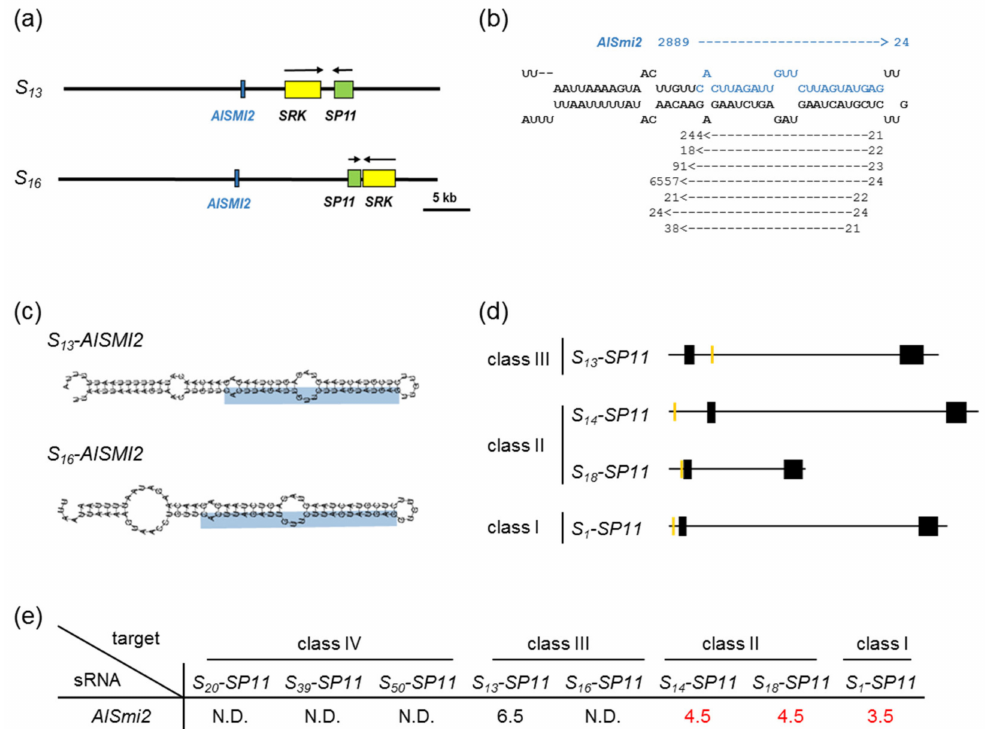
Figure 4. Identification of the candidate sRNAs controlling dominance–recessivity relationships: class III > (class II, class I). ( a ) Schematic diagrams of the S locus in the S 13 haplotype (ADBK01001387) and the S 16 haplotype (HQ379629). Green, yellow, and blue boxes indicate SP11, SRK , and AlSMI2, respectively. ( b ) Massively parallel sequencing analysis of sRNA expression from the S 13 -AlSMI2 inverted repeat sequence. sRNAs obtained from more than 10 reads were mapped against the S 13 -AlSMI2 inverted repeat sequence. Arrows indicate mapped sRNAs and their directions. Numbers at the tips of arrows indicate the obtained read numbers, and numbers at the ends of arrows indicate the base length of each sRNA. Bases in blue indicate the 24-nt AlSmi2 region. ( c ) Stem-loop structures of AlSMI2 of the S 13 and S 16 haplotypes predicted by RNAfold [20]. The predicted 24-nt mature AlSmi2 is shown in blue. ( d ) Schematic diagrams of the SP11 genomic regions of the S 13 , S 14 , S 18 , and S 1 haplotypes. Black boxes indicate exon regions of SP11 , orange boxes indicate the target region homologous to AlSmi2 . ( e ) Sequence similarity between AlSmi2 and SP11 . Each number indicates the mispair score between class-III AlSmi2 and class-IV, class-III, class-II, and class-I S haplotypes of SP11 . N.D., not detected. Mispair scores < 5.5 are shown in